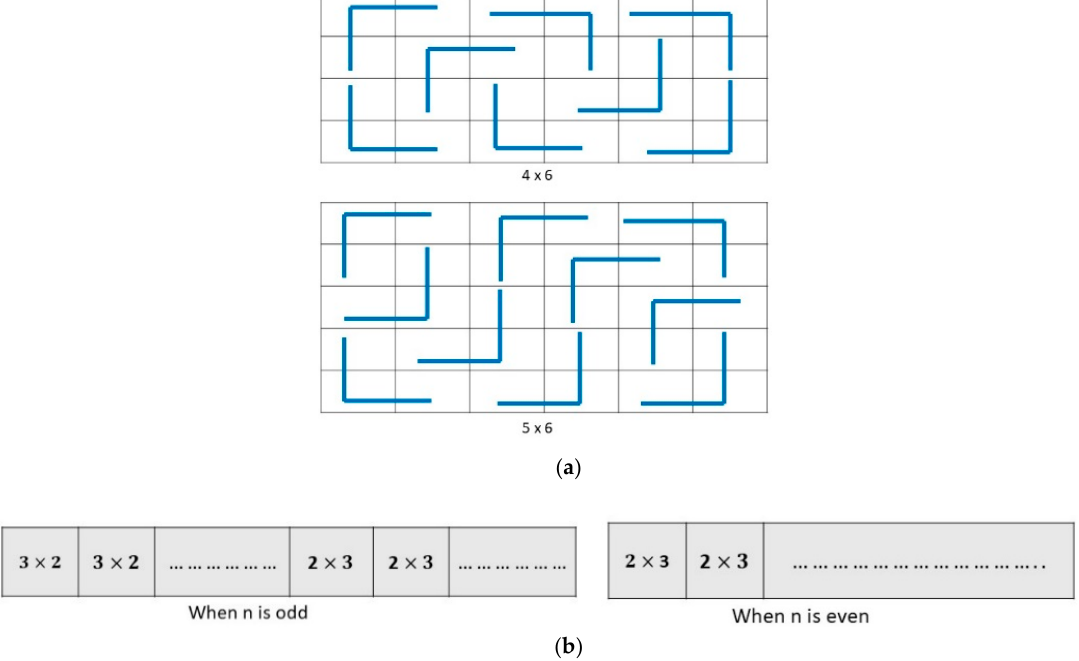
Figure 4. Image Argument for Lemma 2. ( a ) A 4 × 6 and 5 × 6 Tiled rectangle; ( b ) Decomposition on a × b rectangle according to Lemma 2.